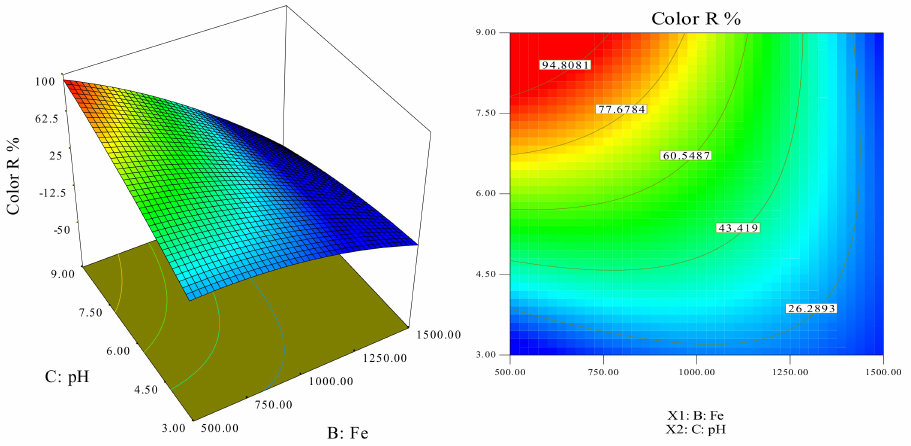
Figure 9. Role of Fe 2+ concentration and pH in leachate decolorization depicted in 3D response surfaces and contour